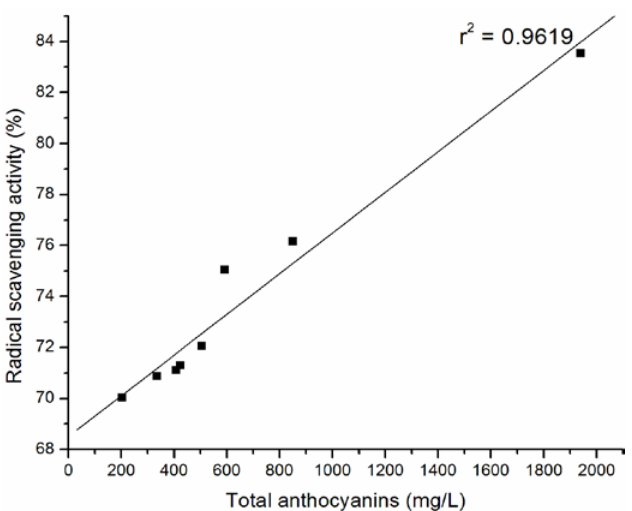
Figure 3. Relationship between radical scavenging activity and sum of non-acylated anthocyanins of selected Cabernet Sauvignon wine